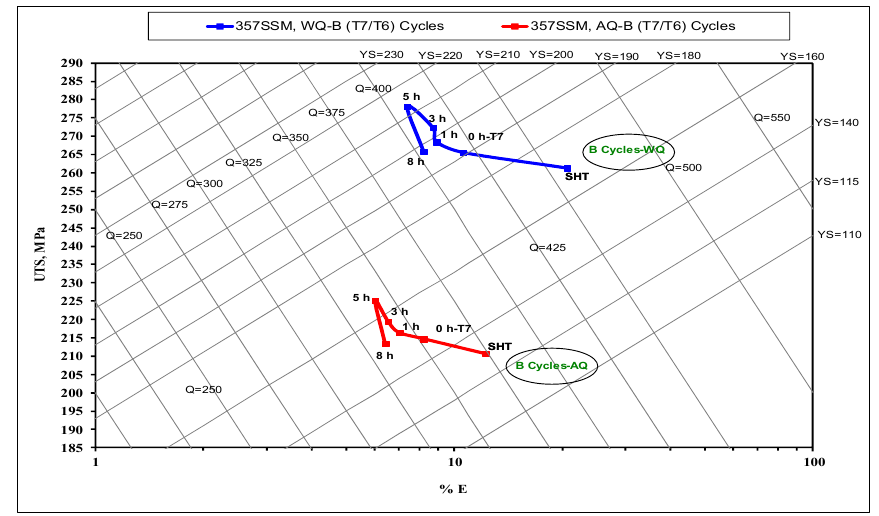
Figure 3. Quality index chart of A357-SSM heat-treated by multiple thermal aging treatments of T7/T6-B cycle with two quenching media.